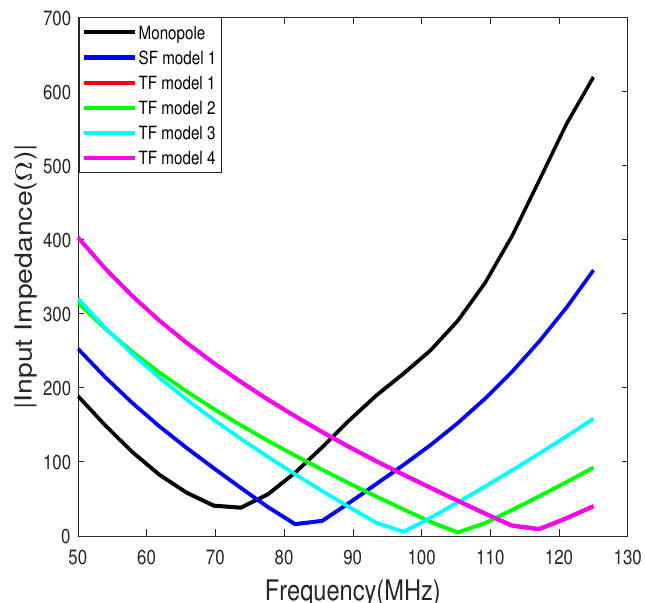
Figure 25. The magnitude of the input impedance of the two-fold antenna models from